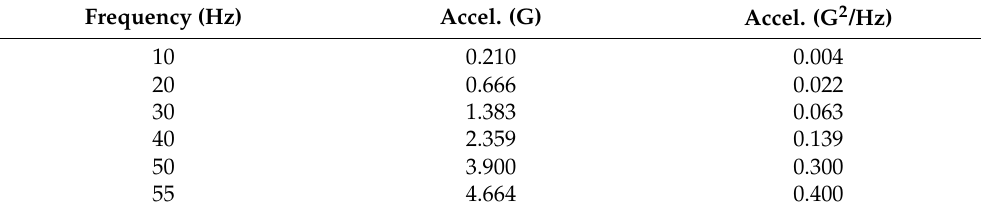
Table 2. Base input PSD.